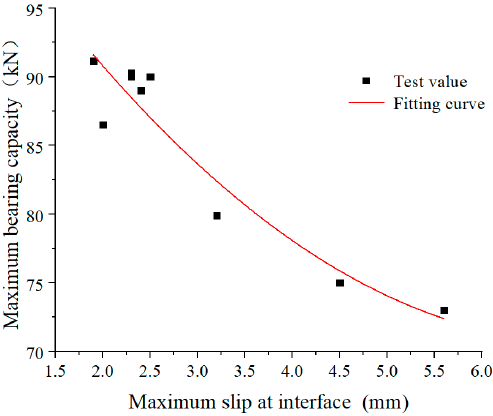
Figure 14. The maximum bearing capacity vs. the maximum slip curve of interface.